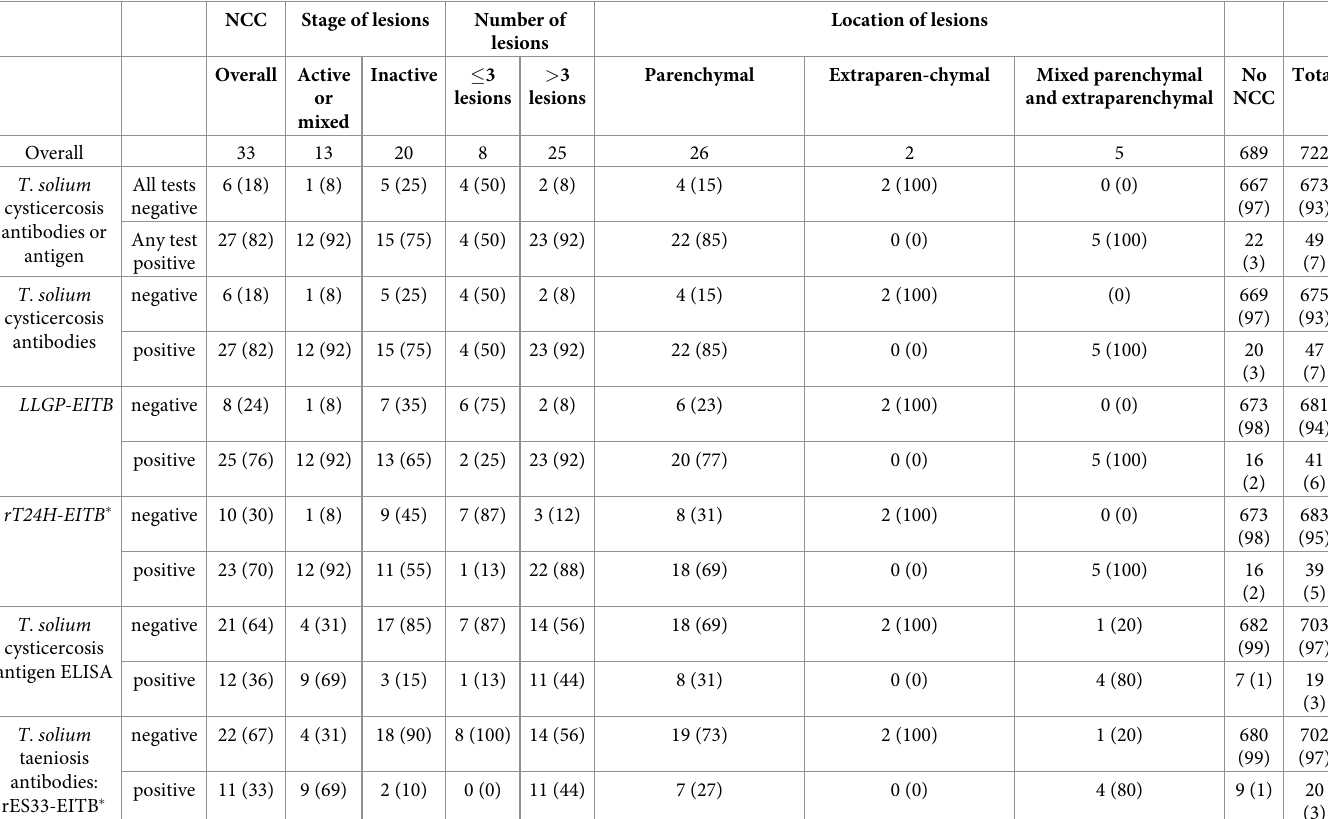
Table 4. Serological results by stage, number, and location of neurocysticercosis-typical lesions.